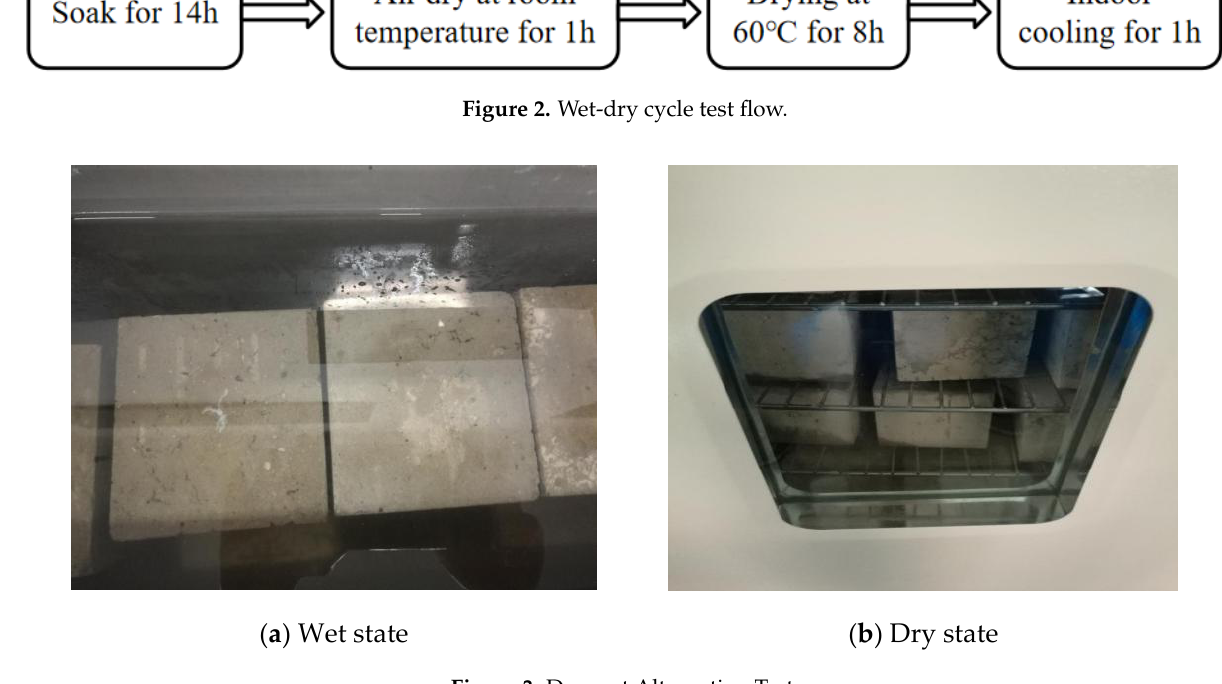
Figure 3. Dry-wet Alternation